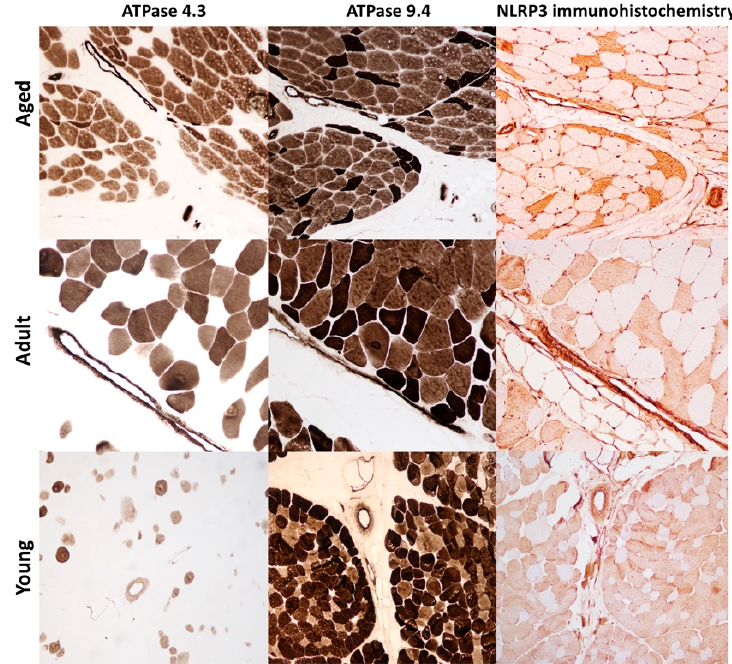
Figure 4. Selective expression of NLRP3 inflammasome in type II muscle fiber. Serial sections of skeletal muscle show a selective expression of NLRP3 inflammasome in type II muscle fibers. Moreover, aged animals (Group A) show severe muscular atrophy restricted to type II fibers stained white (ATPase pH 4.3) or dark brown (ATPase pH 9.4). In adult animals (Group B) the selective atrophy is mild, and it is absent in muscle of young animals (Group C). Immunohistochemistry was performed with HRP method and Mayer’s hematoxylin